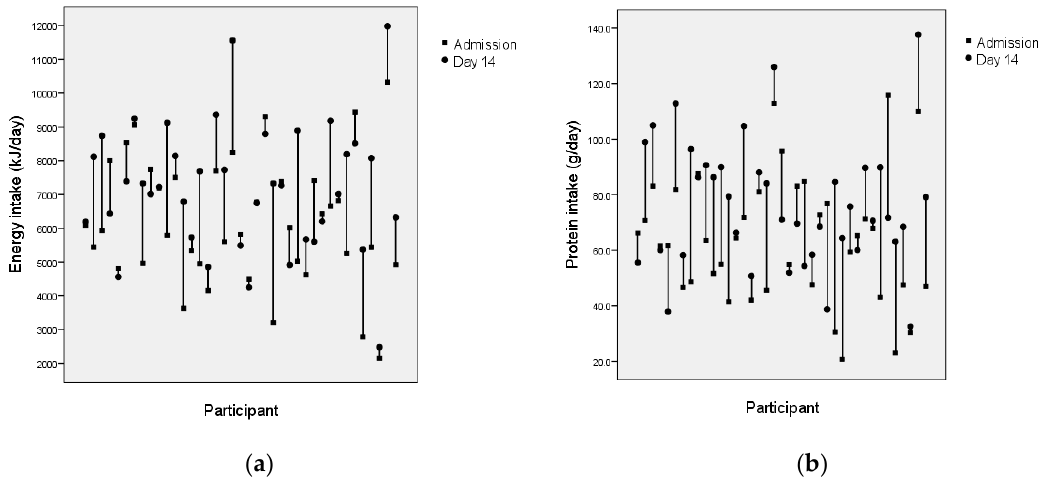
Figure 2. ( a ) Change in energy intake between admission and day 14 for individual participants ( n = 39). ( b ) Change in protein intake between admission and day 14 for individual participants ( n = 39).